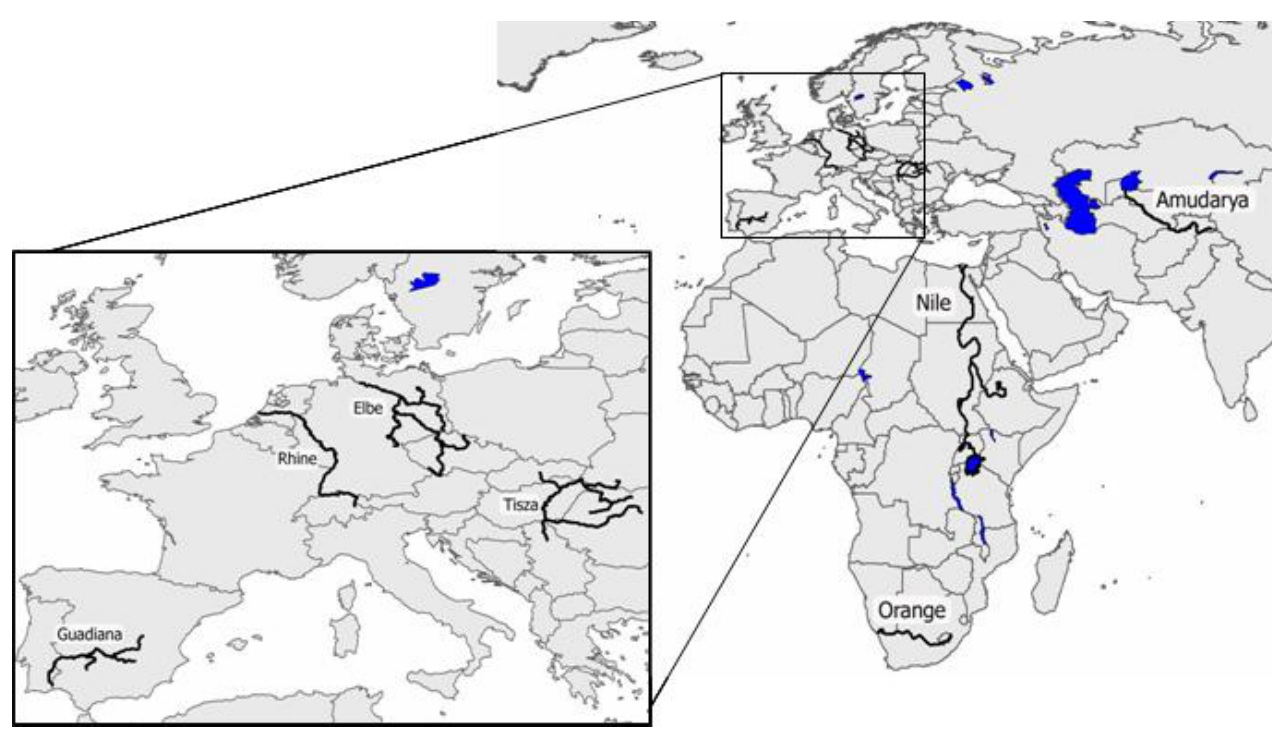
Fig. 3. Map of the seven studied river